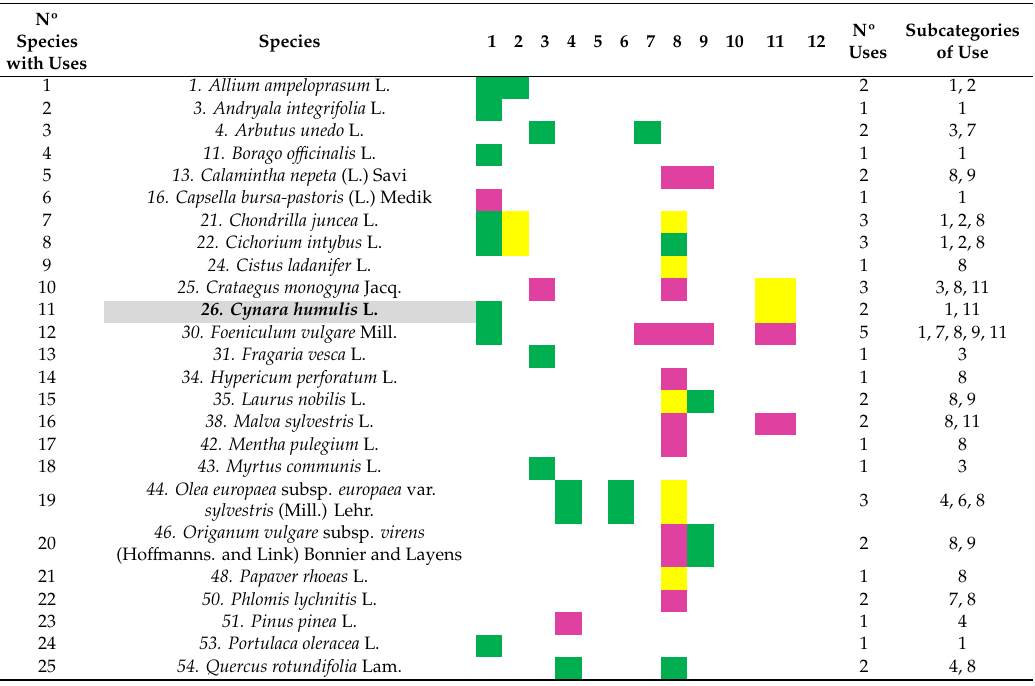
Table 7. Uses obtained in Hornachos contrasted with the data collected in the Spanish Inventory of Traditional Knowledge [20]. This includes uses that already appear in Extremadura (green), new uses in Extremadura (purple), and new uses in Spain (yellow). Hornachos rejected uses are marked with an “X” by their relative interpretation. In bold the highest number of uses obtained by one